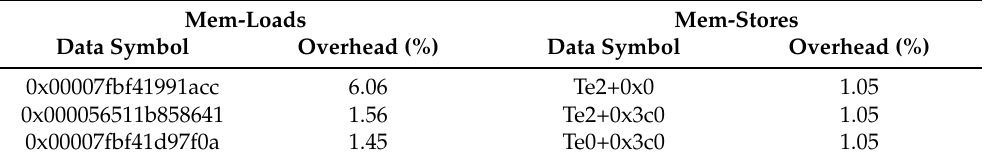
Table 3. Results of Flush+Flush attacking